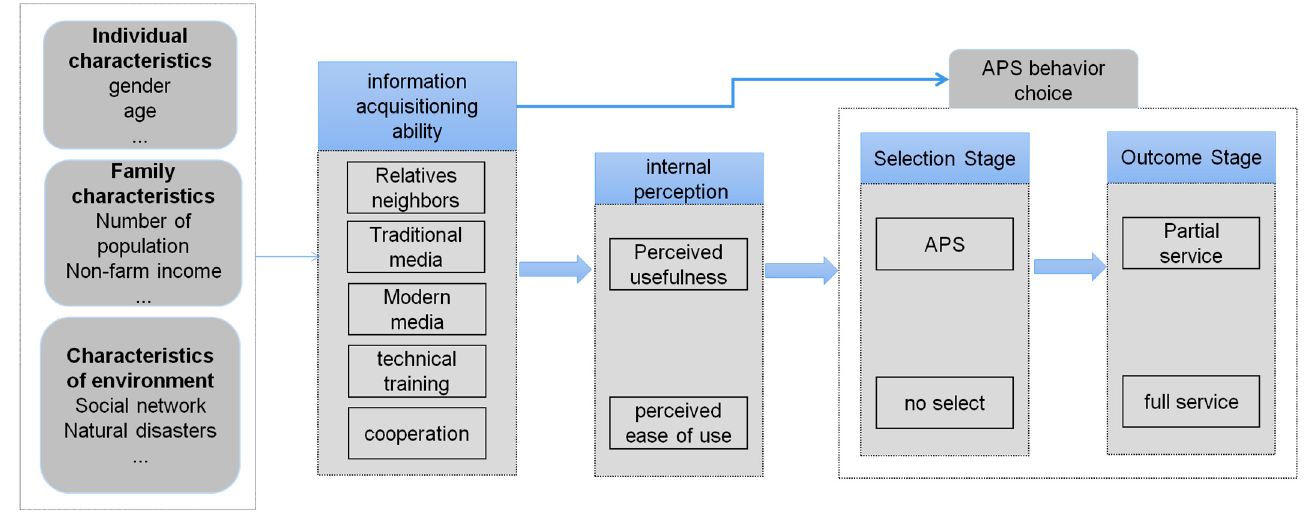
Figure 1. The theoretical framework of the